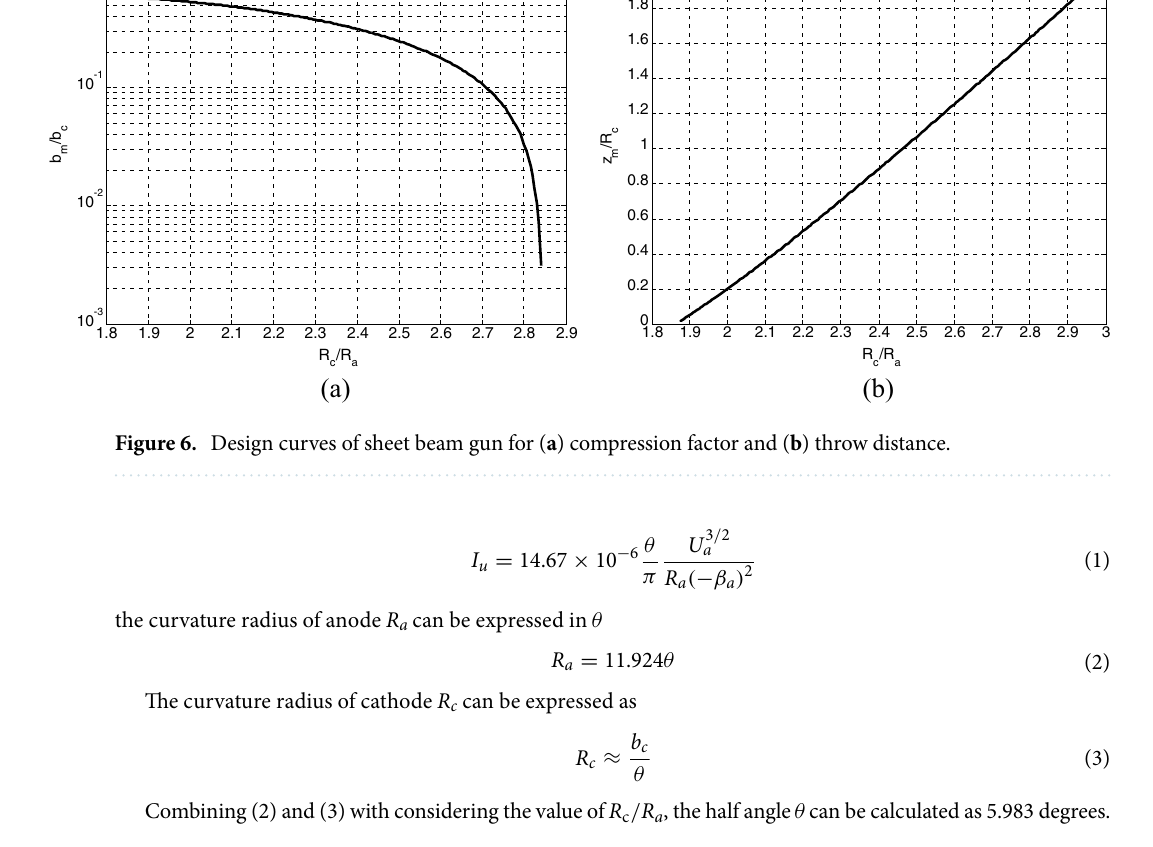
Combining (2) and (3) with considering the value of R c / R a , the half angle θ can be calculated as 5.983 degrees. Determination of other parameters for sheet beam gun. According to the following formulas (4), (5), (6), the value of R c , R a , and the spacing from cathode to anode d K a can be calculated as 3.070 mm, 1.246 mm, 1.814 mm, respectively.